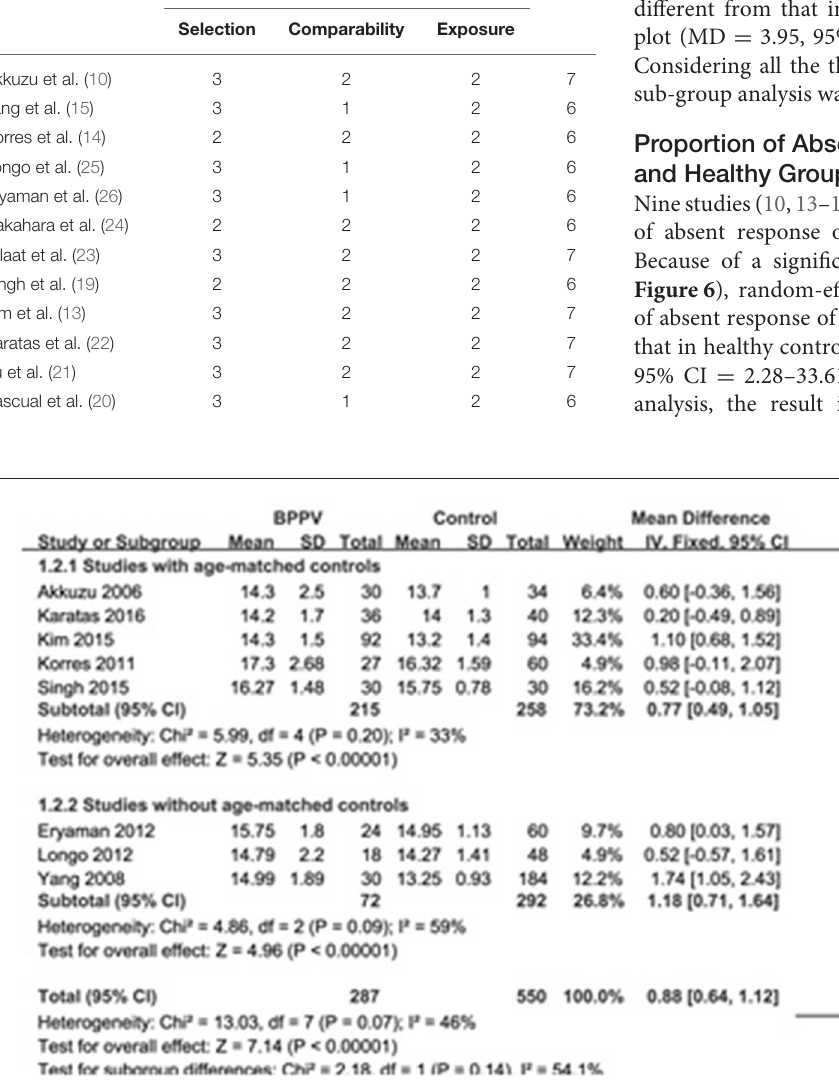
Frontiers in Neurology |